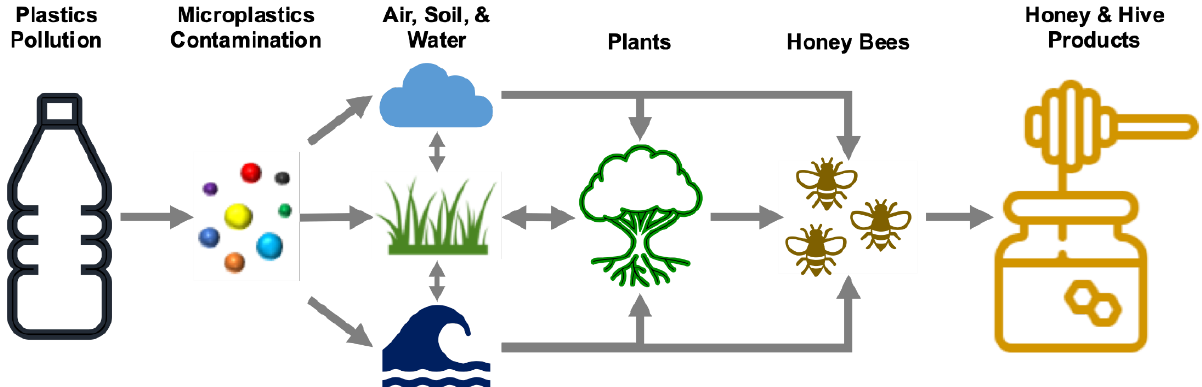
Figure 1. Microplastic particle mass flow in the environment and potential translation into honey bees and other hive products.